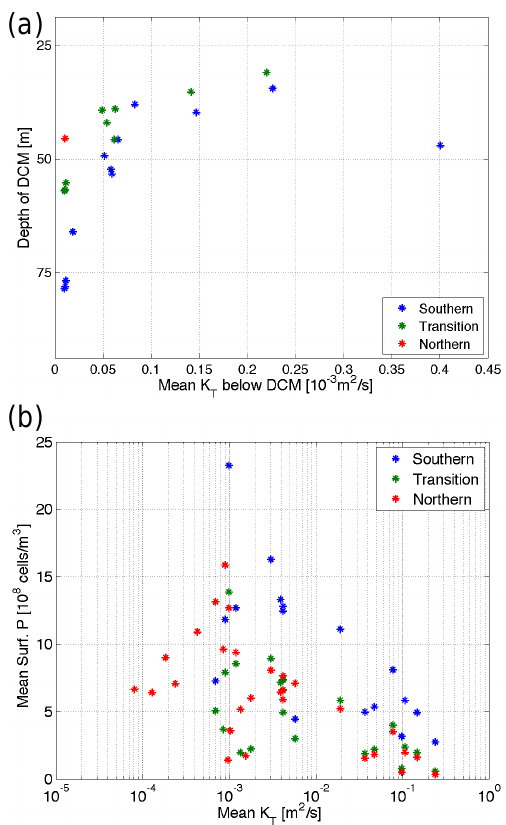
Fig. 11: Nutrient concentration results of the sensitivity study based on the vertical mixing shown in Fig 9 and the three reference stations: southern, transition and northern (top to bottom). The red boxes show the according reference state. Figure 12. Comparison of the model results for the three reference Fig. 12: Comparison of the model results for the three ref- stations. (a) Depth of the DCM as a function of the mean vertical erence stations. (a) Depth of the DCM as a function of the mixing below the DCM. (b) Mean surface phytoplankton concen- mean vertical mixing below the DCM. (b) Mean surface phy- tration for all UCM and homogeneously mixed states. toplankton concentration for all UCM and homogeneously mixed states.